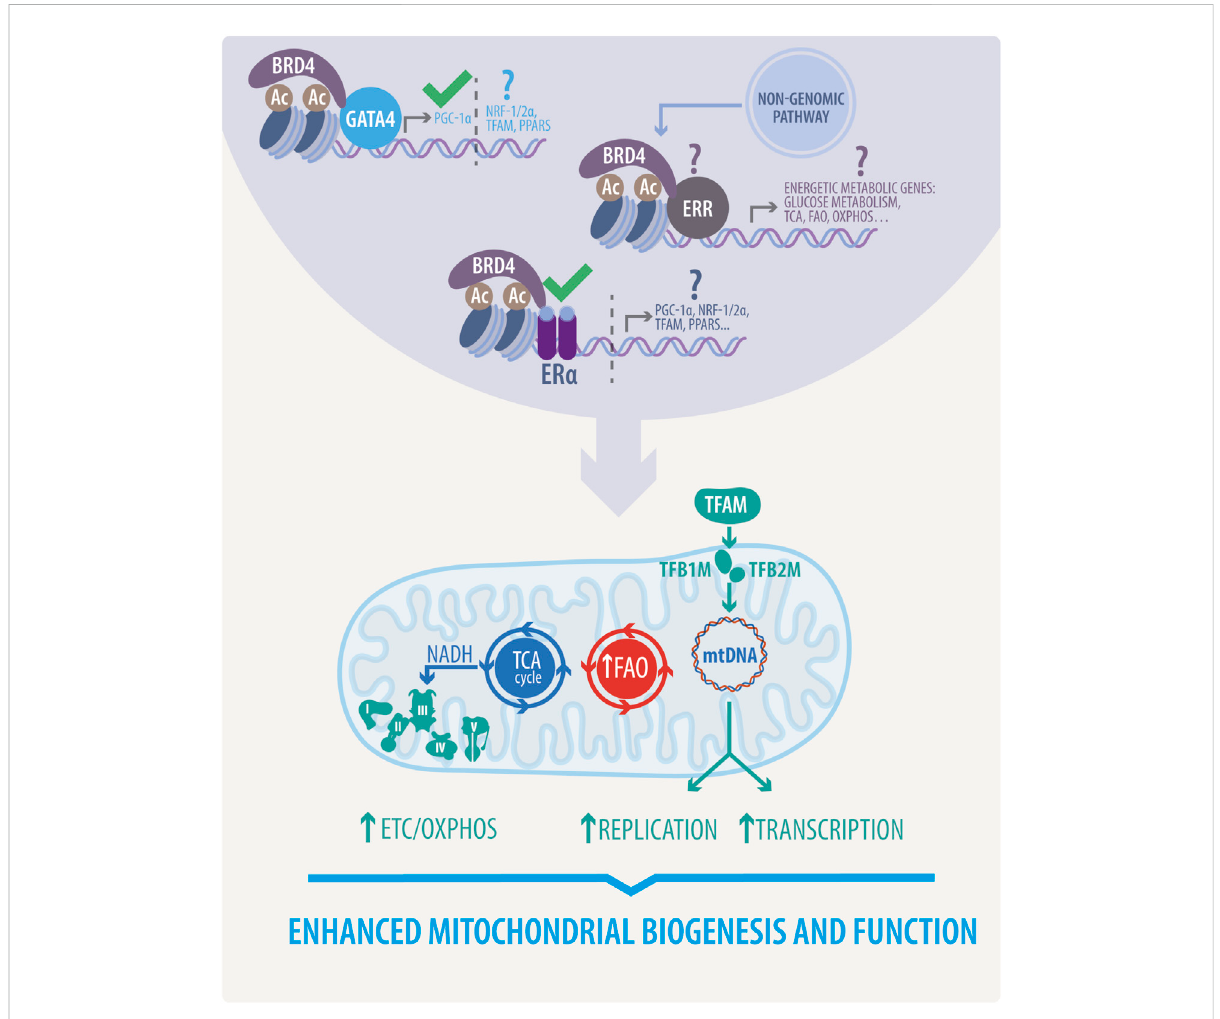
FIGURE 4 Proposed estrogenic bridge in nucleus-mitochondria communication. Estrogenic activity enhances mitochondrial biogenesis and function